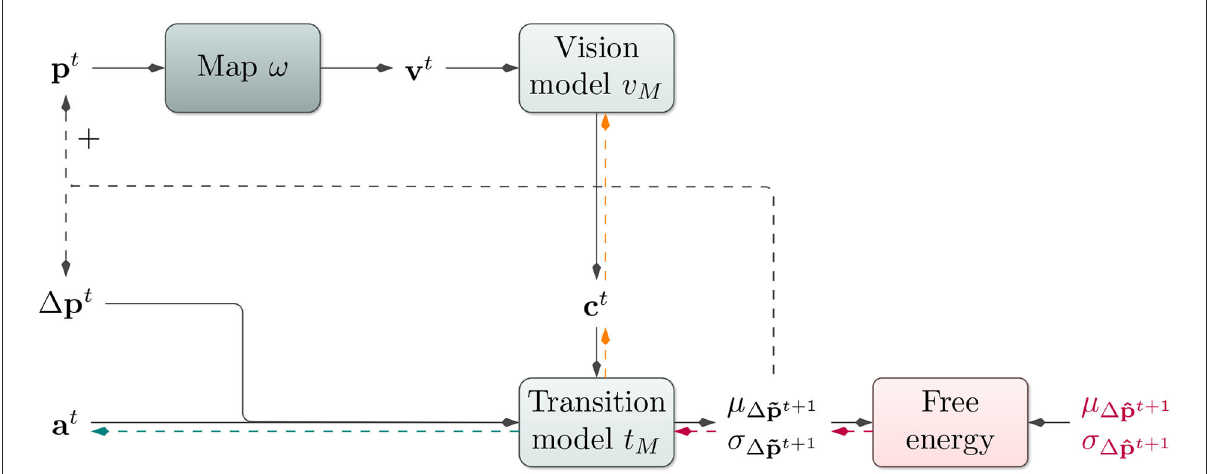
FIGURE2 Affordance map architecture: Based on the current position p t , the architecture performs a look-up in an environmental map ω . The vision model v M receives the resulting visual information v t and produces a contextual code c t . The transition model t M utilizes this context c t , the last change in the position 1 p t , an action a t , and its internal hidden state h t to predict a probability distribution over the next change in position. During training, the loss between predicted and actual change in position is backpropagated onto t M (red arrows) and further onto v M (orange arrows) to train both models end-to-end. During planning, the map look-up is performed using position predictions. For gradient-based active inference, EFE is backpropagated onto the action code a t (red and green arrows). For planning with the cross-entropy method, a t is modified directly via evolutionary